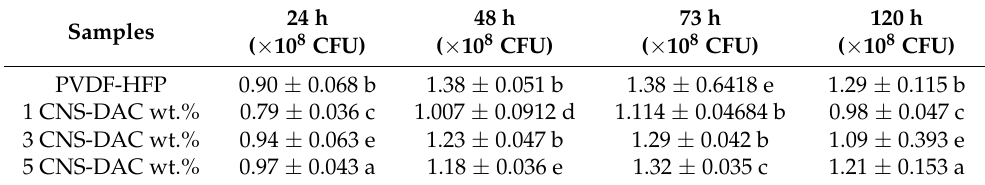
Table 1. The survival cells’ quantity compared to the exposure time for the composite membranes. Samples